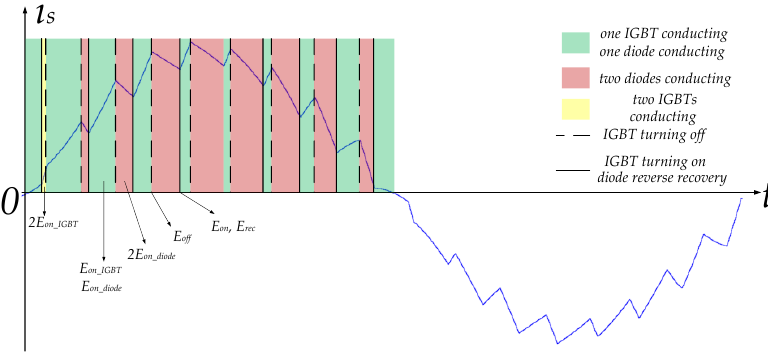
Figure 4. Loss analysis of the single phase PWM rectifier during a modulation period. The green region corresponding to one IGBT conduction loss and one diode conduction loss, the red region corresponding to the conduction loss of two diodes, and the yellow region is corresponding to the conduction loss of two IGBTs. The dashed area corresponding to the loss of the IGBT turning off, and the solid line region is corresponding to the IGBT turn-on loss and diode reverse recovery loss. In the half modulation cycle, IGBT conduction loss, IGBT turn-on loss, IGBT turn-off loss, diode conduction loss, and diode reverse recovery loss could be written as follows: E con_ IGBT_ half = ∑{ V CE [ I C ( t 2 i - 1 )] ∙I C ( t 2 i- 1 ) ∙T T_ 2 i - 1 } + m+ 1 i= 1 2 V CE [ I C ( t 2 )] ∙I C ( t 2 ) ∙T T_ 2